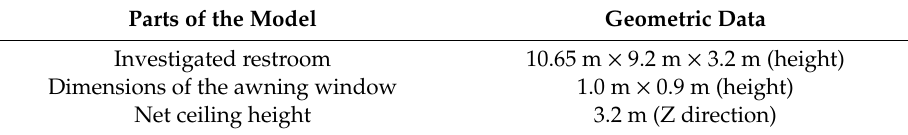
Table 2. Geometric data for restroom under investigation.